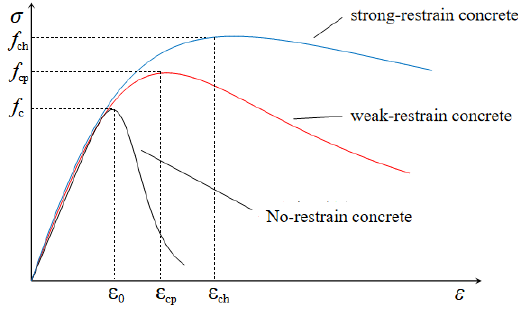
Figure 9. Stress-strain curves for concrete.